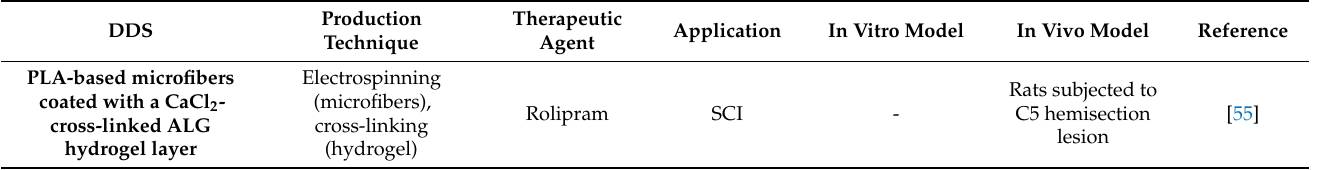
Table 2. Summary of ALG-based DDSs for SCI and PNI application. DDS description, production technique, therapeutic agent delivered, in vitro and in vivo models exploited for efficacy assessment are